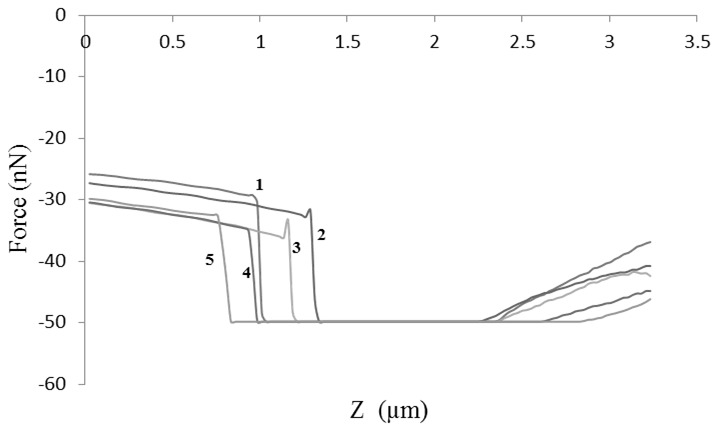
Changes in AFM adhesion force upon indentation of theophylline particle.The graph shows the retraction part of the curve used to obtain adhesion force. The force decreased upon subsequent indentations (from 1 to 4) followed by a little increase in force due to slippage of surface crystallite.